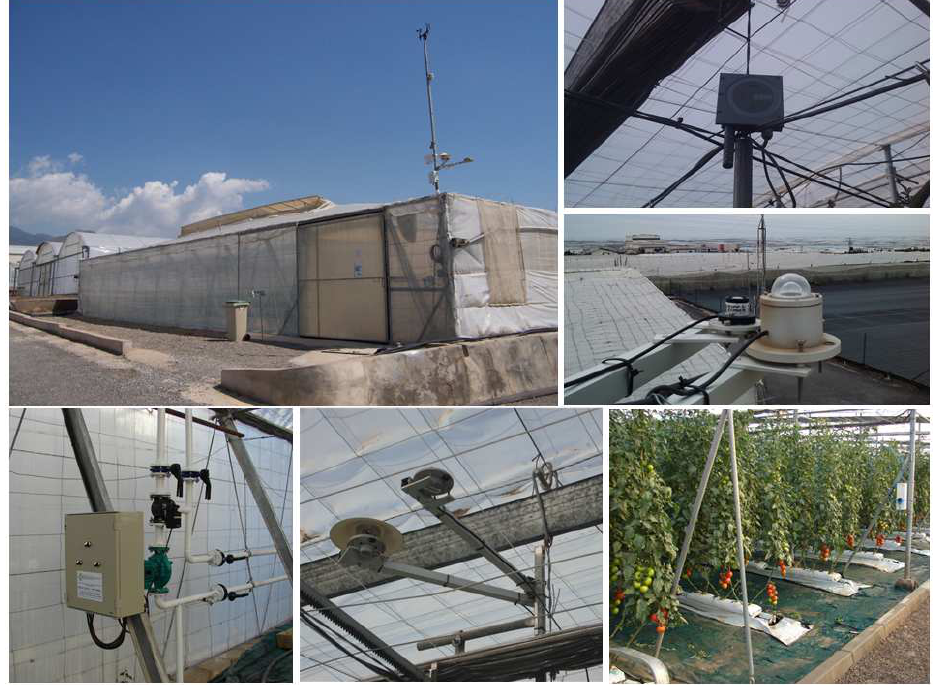
Figure 5. Greenhouse facilities used for the experiences performed in this work. From left to right and from top to bottom on the figure: Greenhouse, CO radiation, Heating system, Solar and PAR radiation inside the greenhouse, and the tomato crop